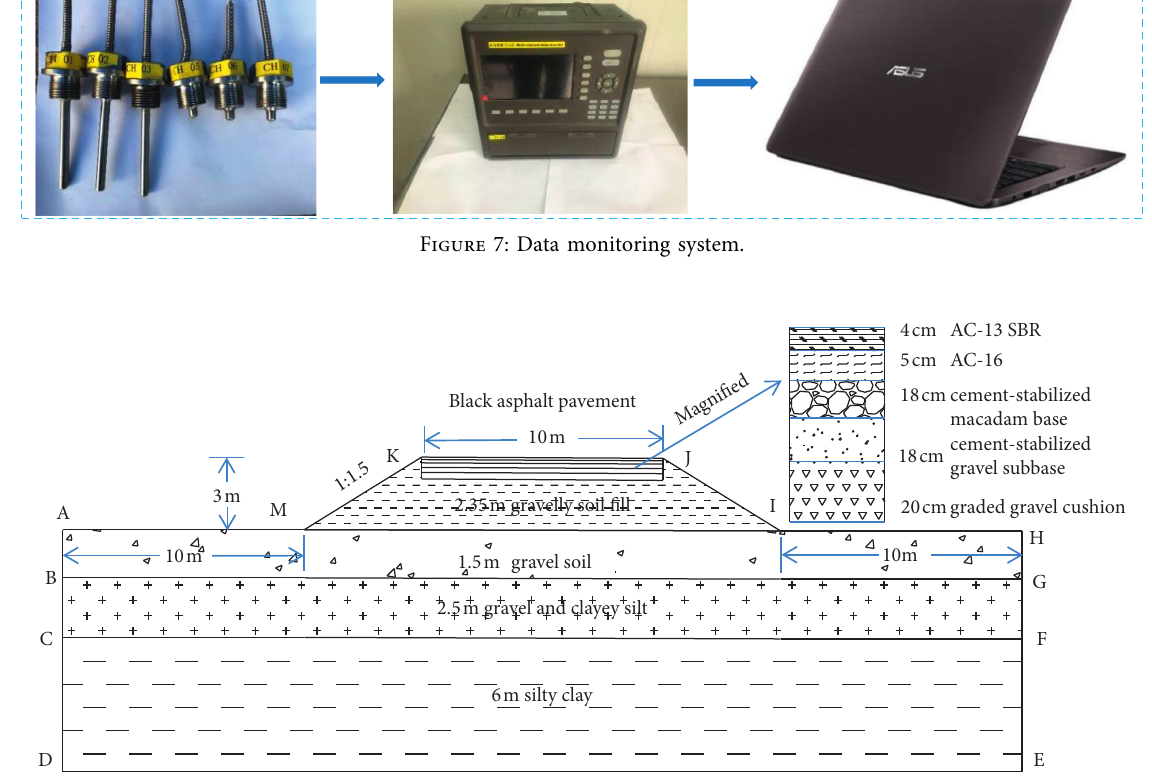
Figure 8: Two-dimensional numerical analysis model.